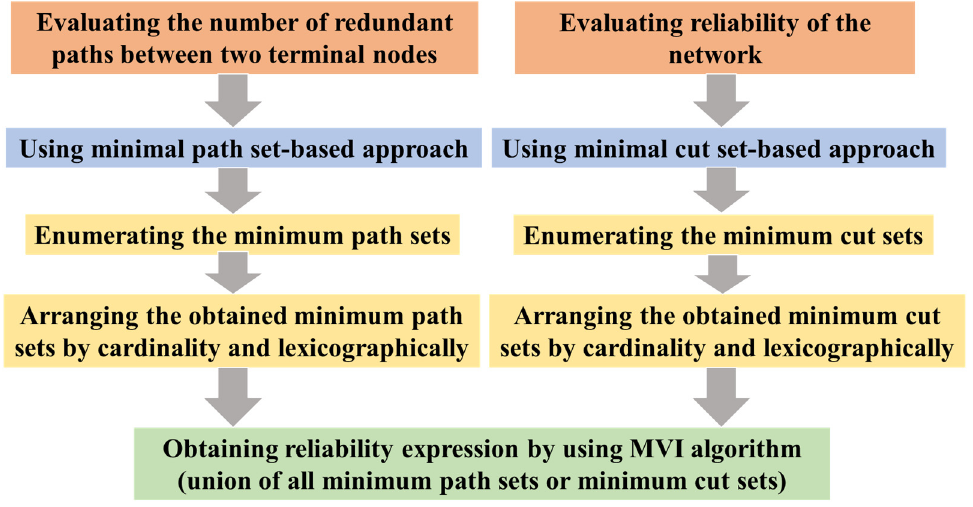
Figure 6. The flow chart of the overall evaluation process.